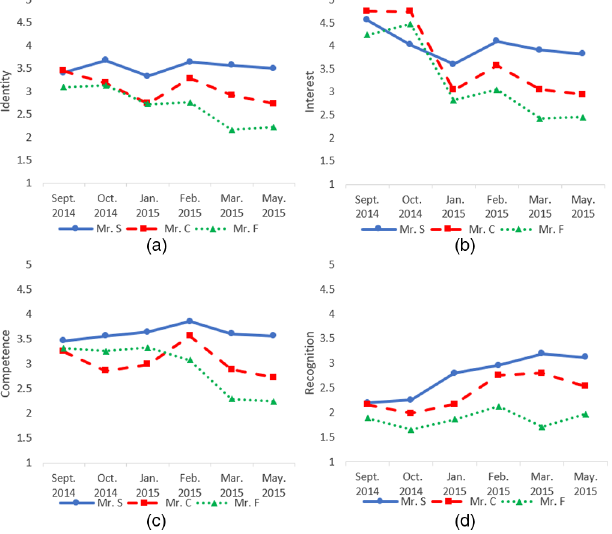
FIG. 2. Average score of class identity, interest, competence or performance, and recognition in the school year 2014 – 2015.